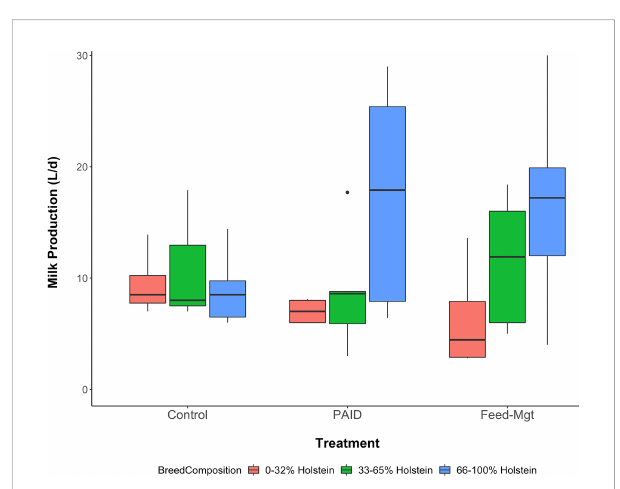
FIGURE 7 Milk production (L/d) in Oromia region 3 - 4 weeks after the beginning of the